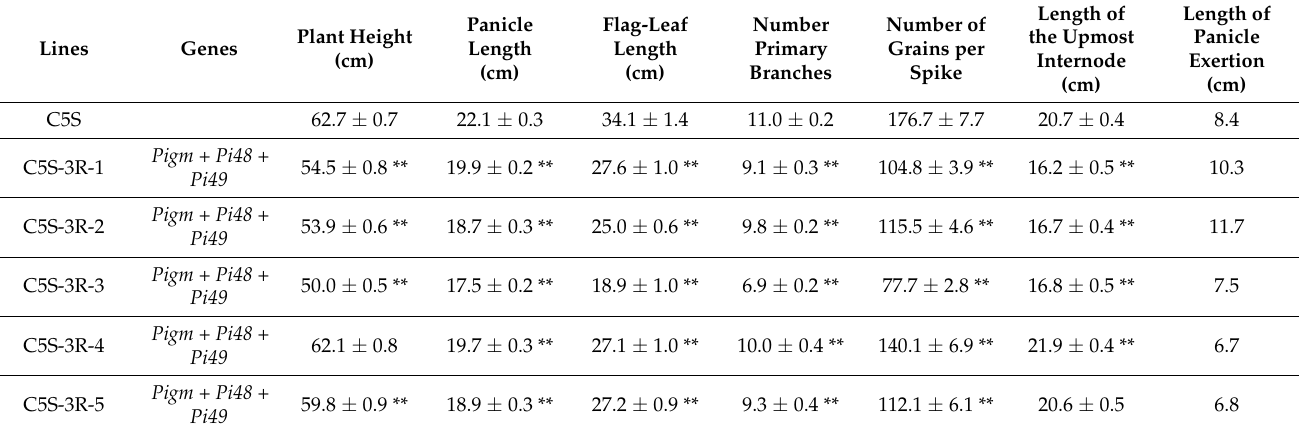
Table 3. Agronomic traits of C5S and the improved